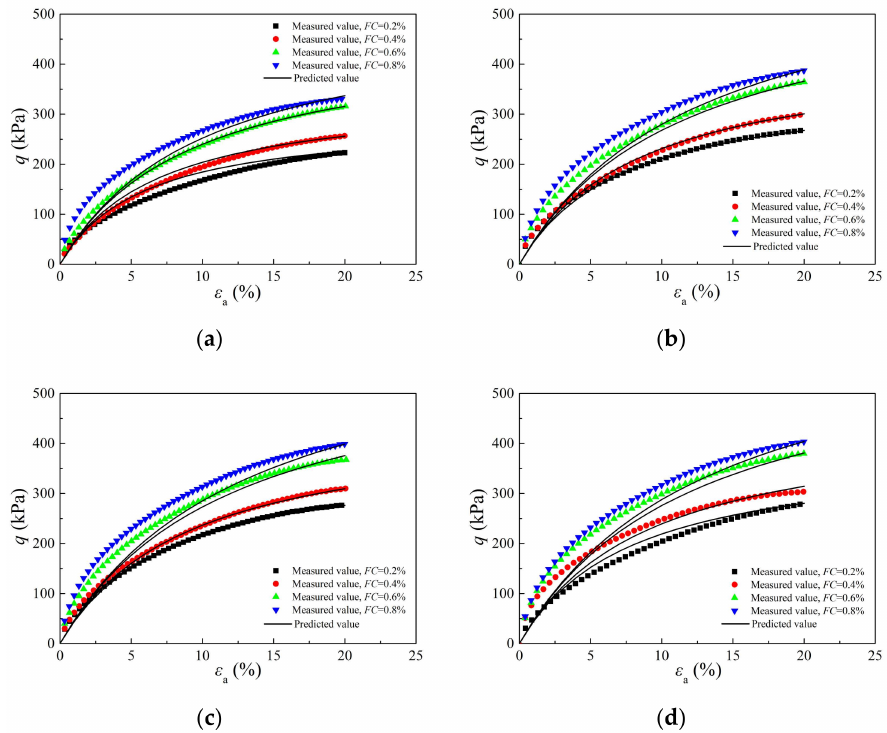
Figure 10. Results comparison between measured and predicted results under 100 kPa cell pressure: ( a ) FL = 4 mm; ( b ) FL = 8 mm; ( c ) FL = 12 mm; ( d ) FL = 16